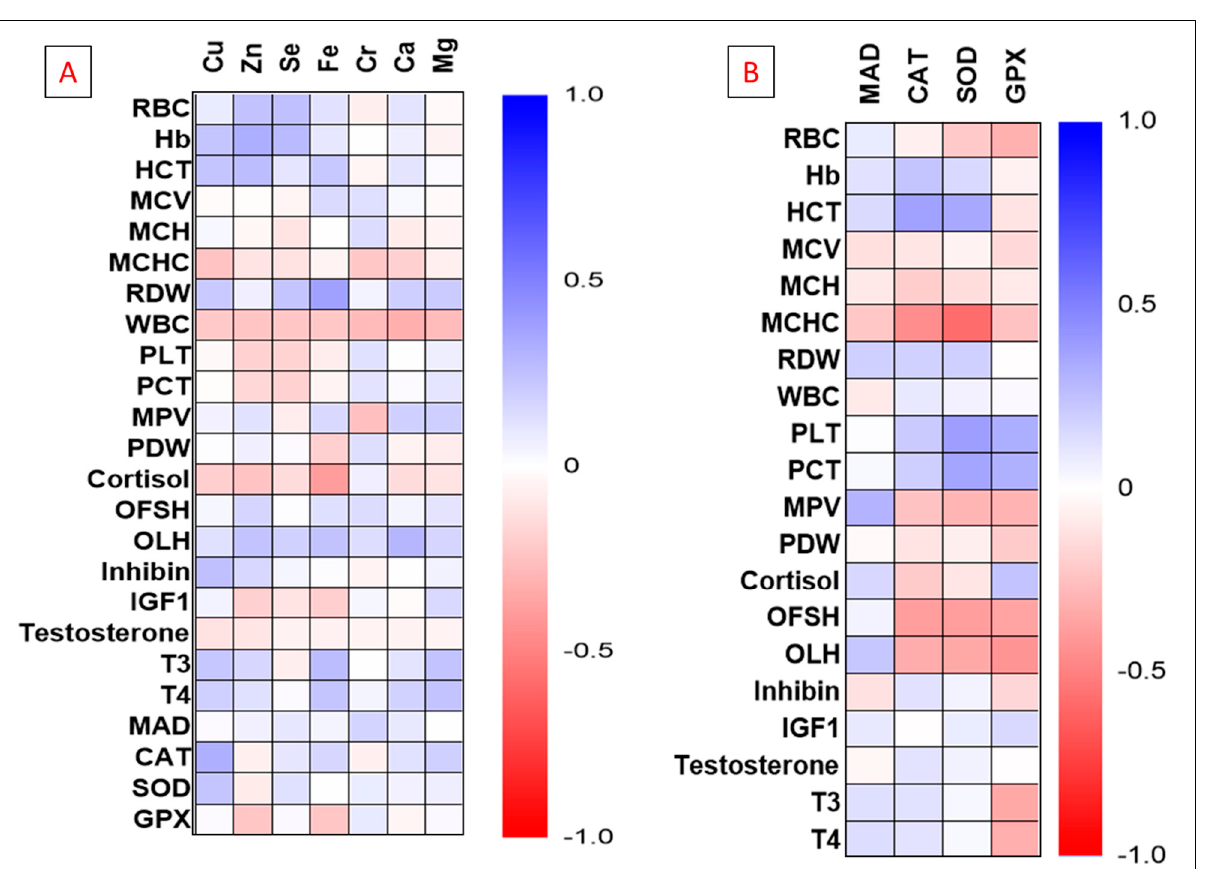
Figure 4. Heatmap illustrating the correlation results between plasma element concentrations (Ca, Mg, Cu, Zn, Se, Cr, Fe) and hematology, oxidative stress markers, and plasma hormonal profile ( A ). The relationship between oxidative stress markers (MAD, SOD, GPX, CAT) and hematology and hormonal profile throughout the study period was also presented ( B ).